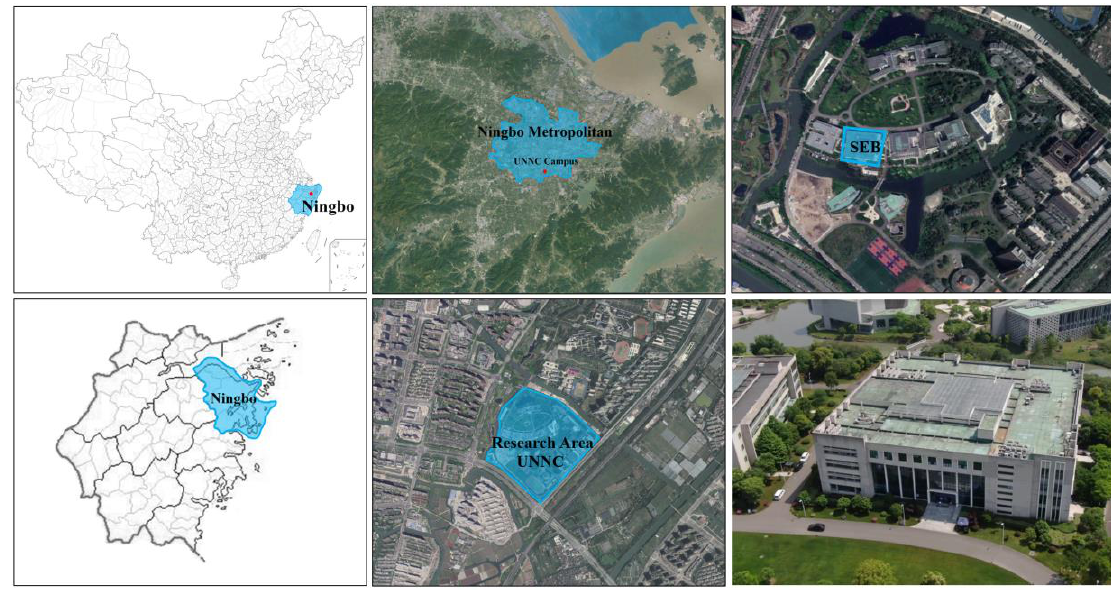
Figure 1. The case-study building—the SEB.